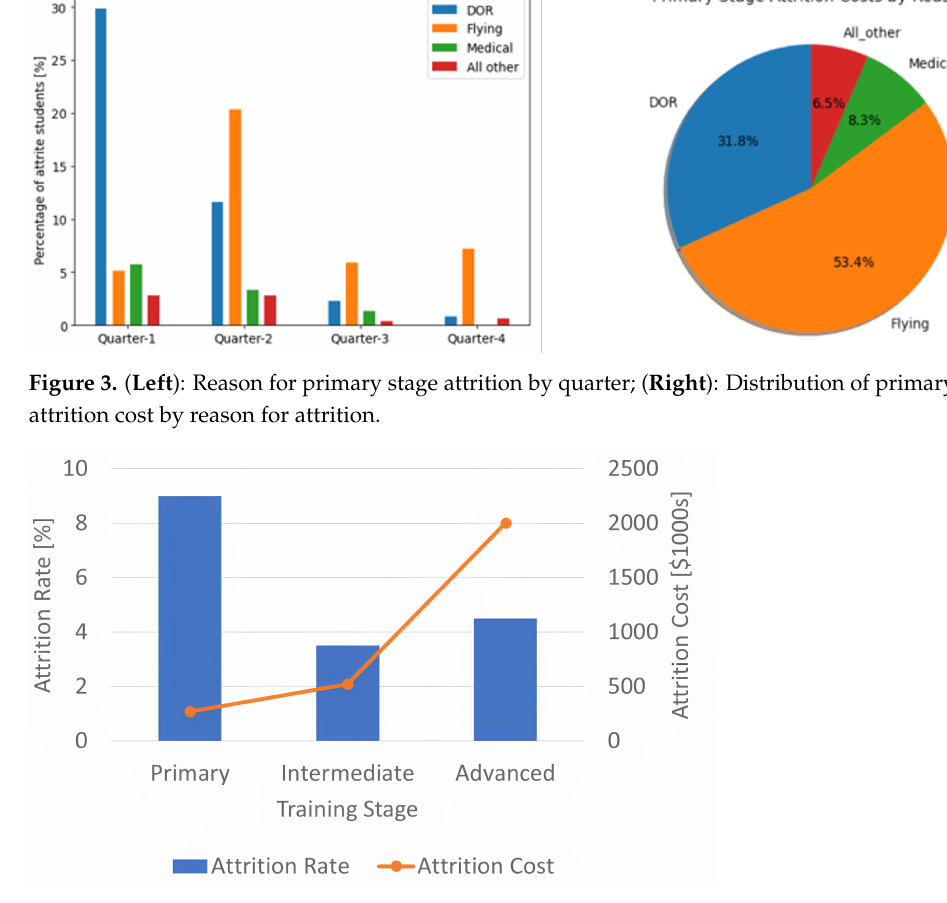
Figure 4. Naval student aviator attrition rates and associated cumulative attrition costs for the strike pipeline at different stages of